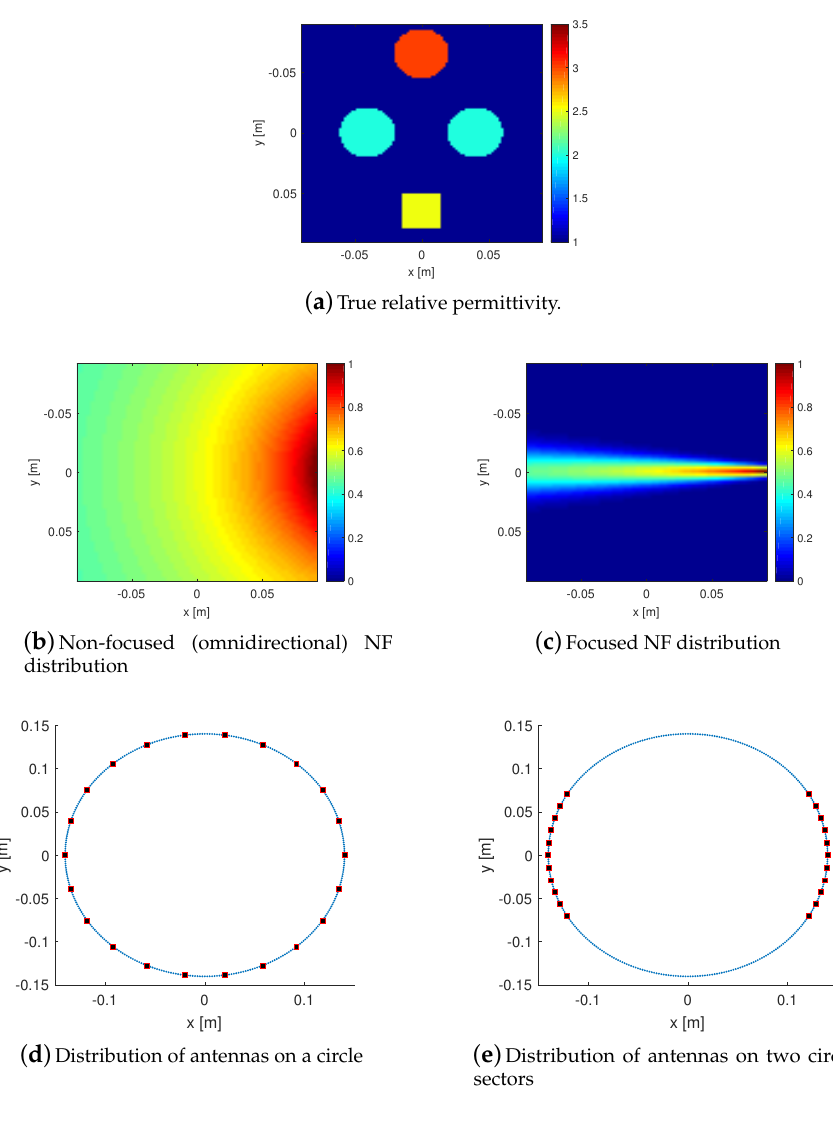
Figure 3. ( a ) represents the true relative permittivity profile. The two light blue circles are assumed to be the OI, and the other two side objects (red and yellow) are the undesired scatterers. ( b , c ) represent the non-focused (omnidirectional) and focused incident fields, respectively, which are used to irradiate the imaging domain. ( d , e ) represent two type of data collection schemes with antennas located either on a full circle or on a two circular sectors,